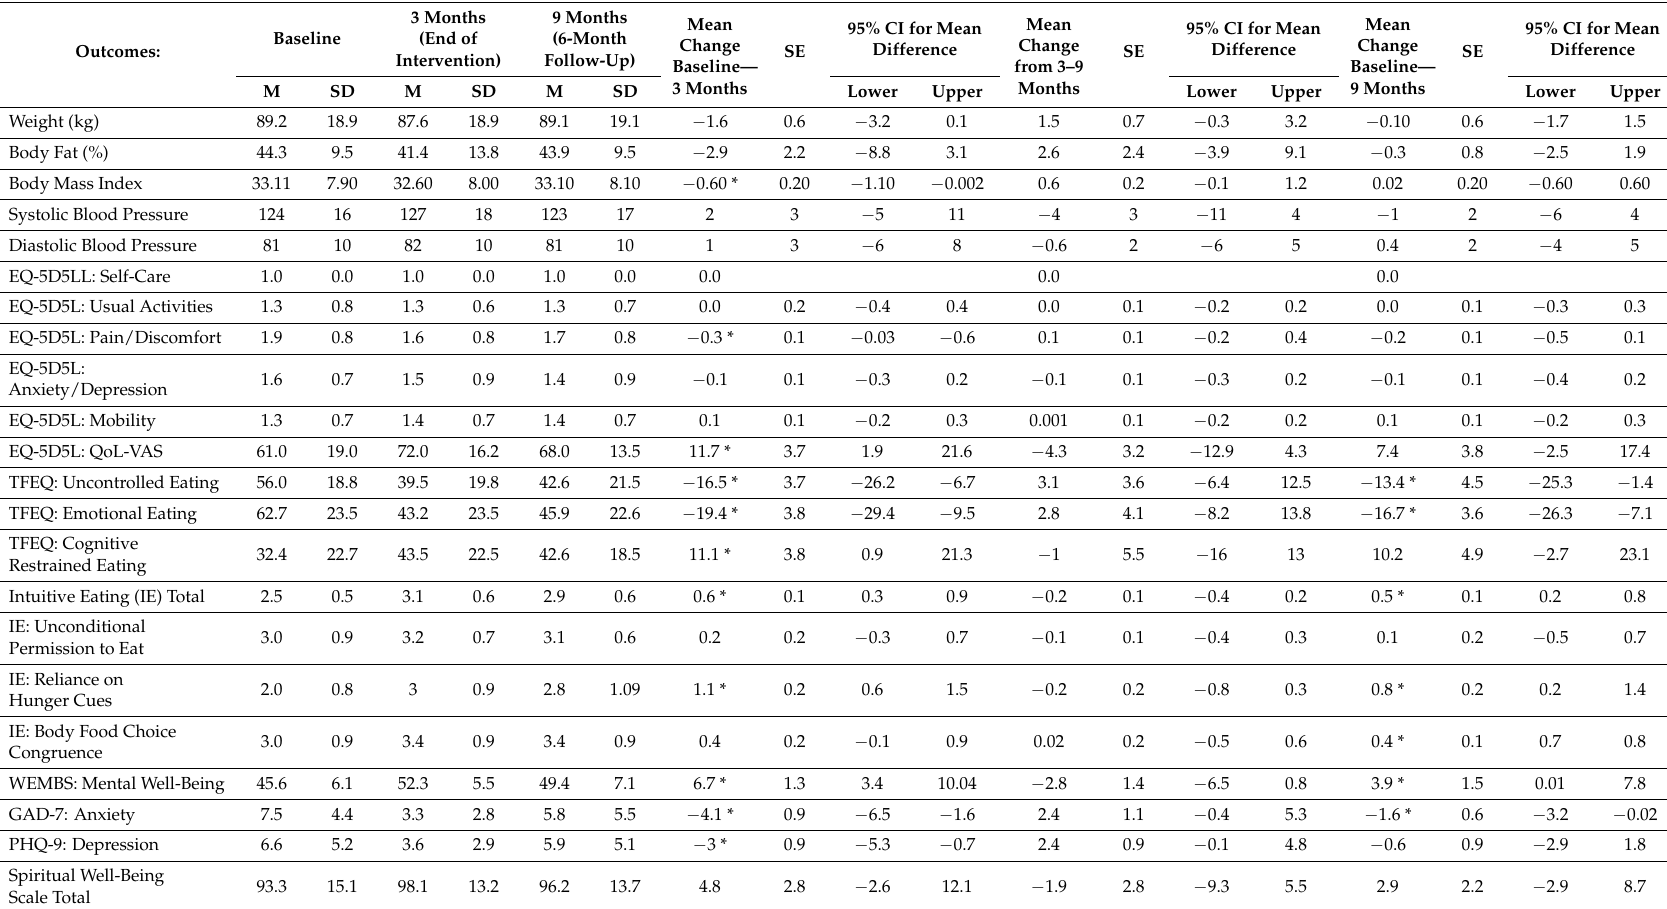
Table 3. Repeated-measures ANOVA displaying the main interaction between changes at baseline three months and nine